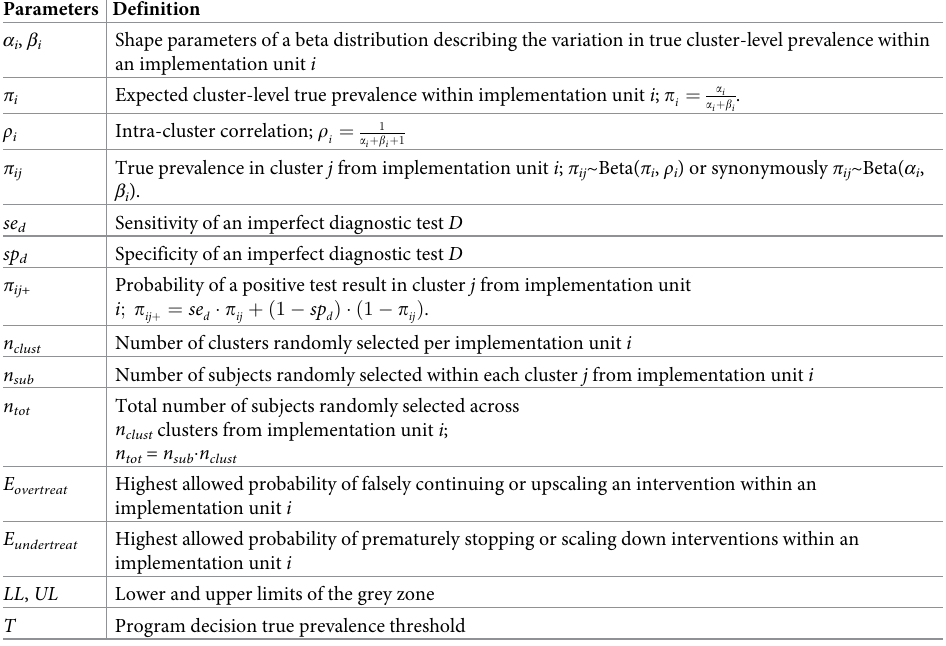
Table 1. Definitions of the parameters that describe the 2-stage LQAS framework. Parameters Definition